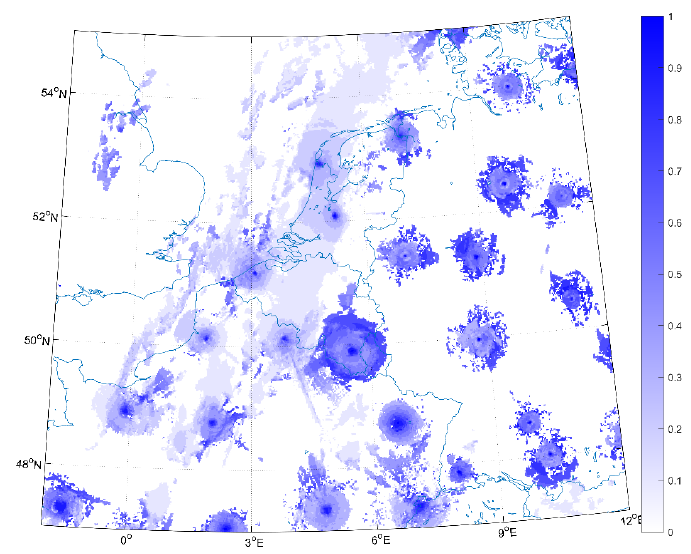
Figure 3. Rain Rate data (mm/h). ( a ): NN retrieval—5 June 2015 17:30; ( b ) Radar ground-truth—5 June 2015 17:30; ( c )